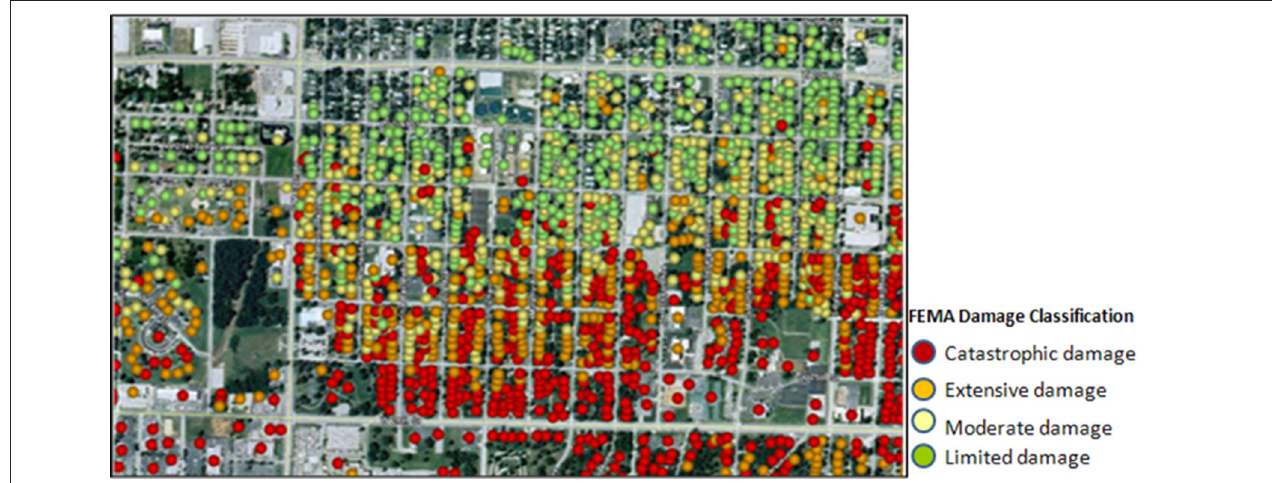
FIGURE 9 | Per-building analysis of damaged buildings in Joplin, MO (2011). Image Credit: ImageCat (used with permission).